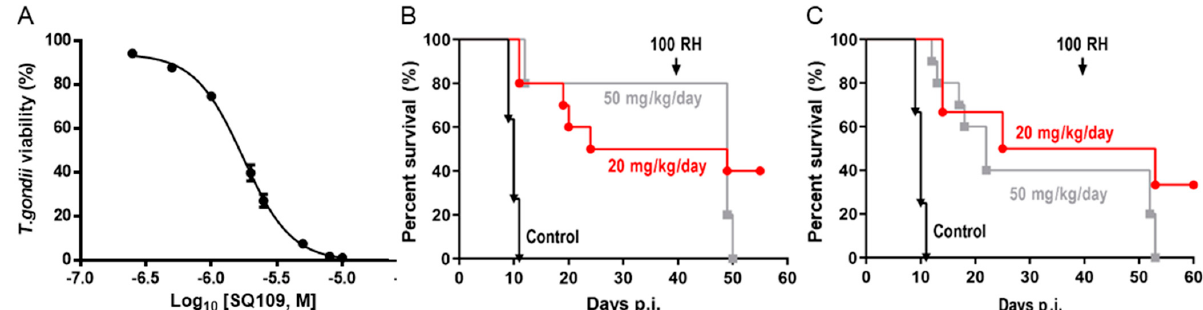
Figure 6. Effects of SQ109 on T. gondii cell growth inhibition in vitro and in vivo activity. ( A ) T. gondii cell growth inhibition. IC 50 = 1.82 µM. T. gondii infected mice treated with vehicle only [ ▲ ], SQ109 (20 mg/kg) [ ● ] or (50 mg/kg) [ ■ ] ( B ) by intraperitoneal route, or ( C ) by oral gavage ( n = 10).